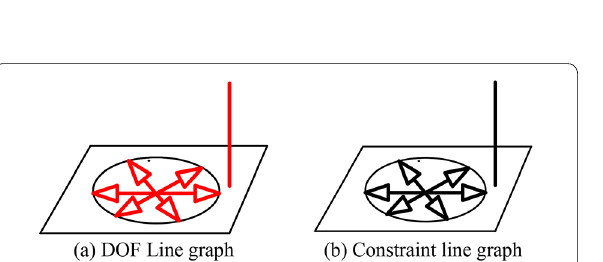
Figure 15 Moving platform F&C line graph